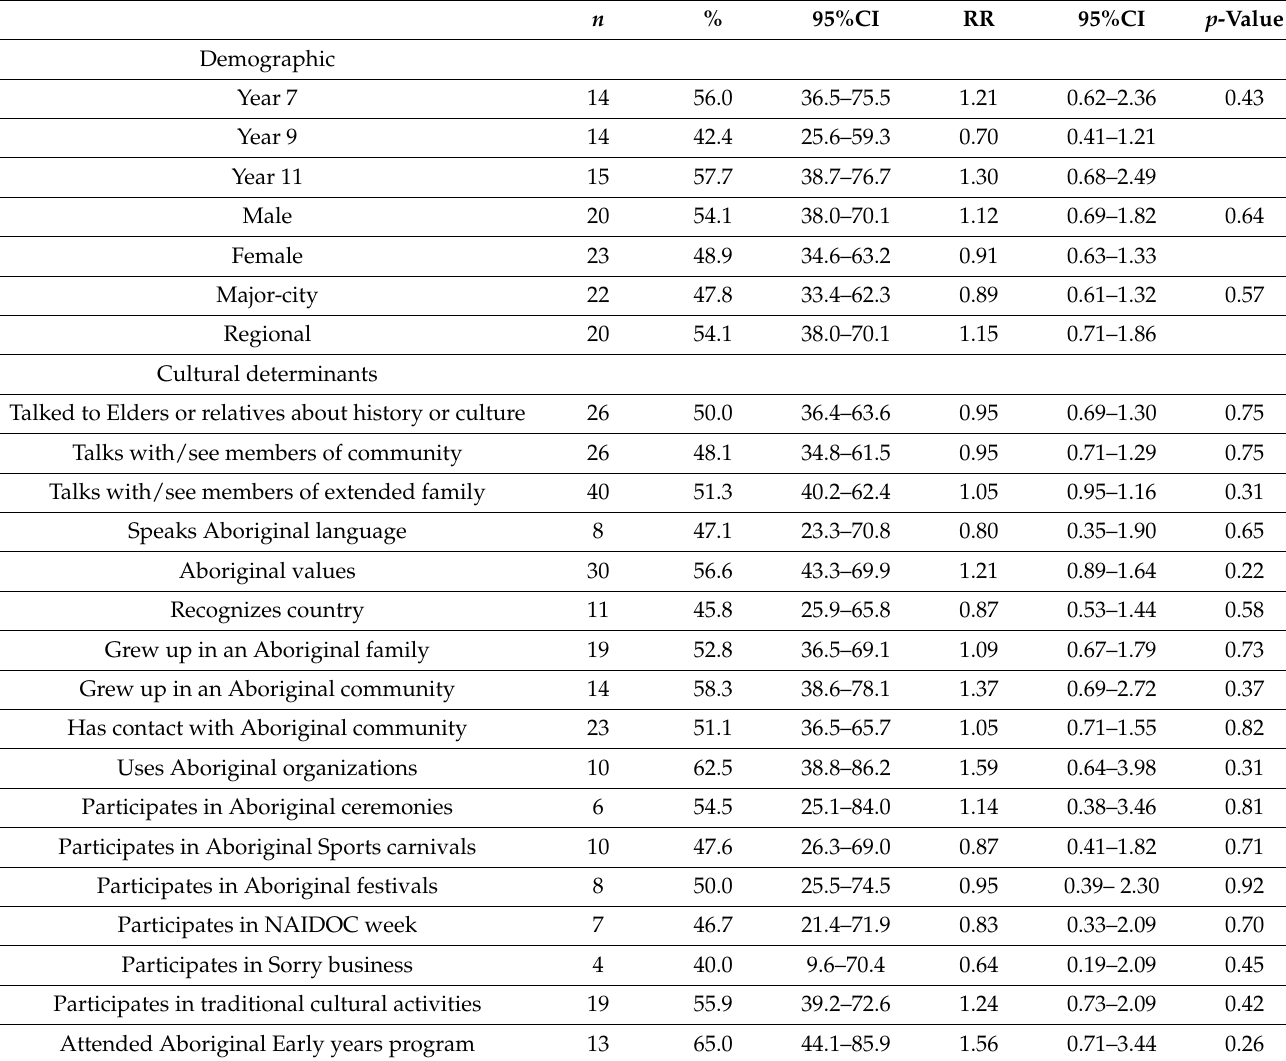
Table 2. Bivariate analysis of demographic and social characteristics and likely being well (Kessler-10 score 10–19). n % 95%CI RR